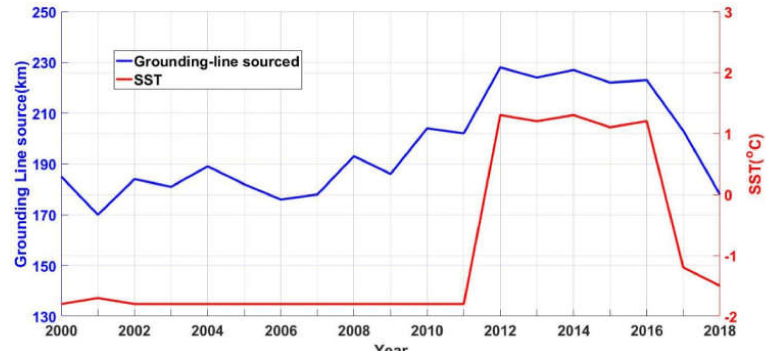
Figure 15. The time series of grounding-line-sourced channel and